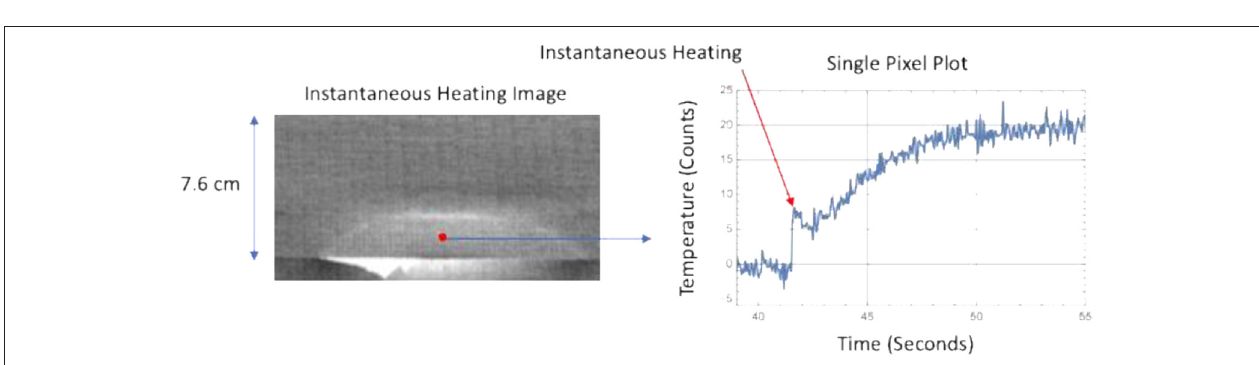
FIGURE 5 | Comparison of instantaneous heating image to ultrasonic inspection for large delamination.